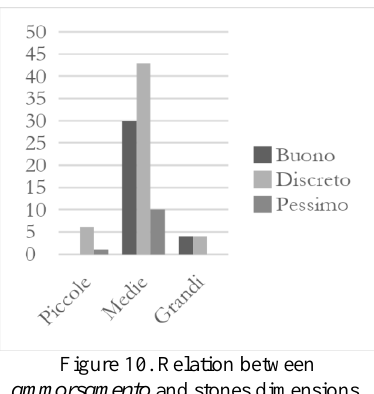
Figure 10. Relation between ammorsamento and stones dimensions.